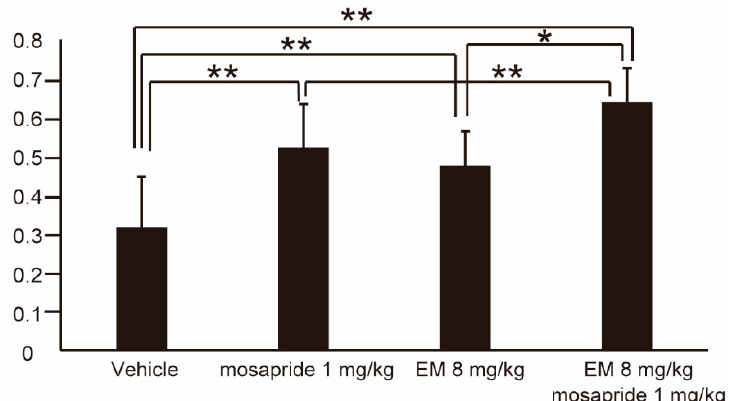
Figure 5. Gastric emptying of human MLNR Tg mice following peripheral (intraperitoneal) administration of vehicle only ( n = 10), mosapride ( n = 9), EM only ( n = 8), or EM + mosapride ( n = 10). Values represent the mean ± SD for the indicated number of animals. * p < 0.05, ** p < 0.01 (One-way ANOVA with Tukey post-hoc test).